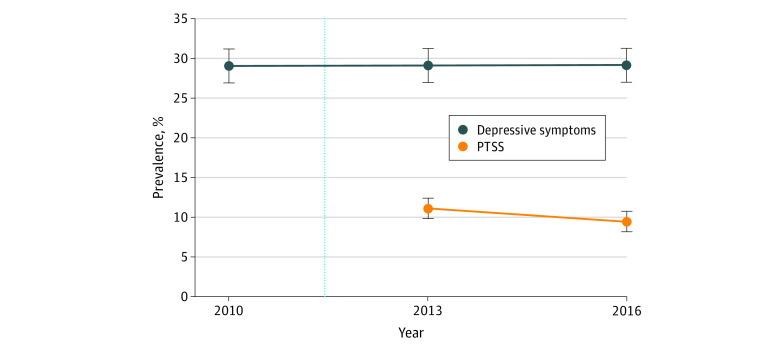
Prevalence of Posttraumatic Stress Symptoms (PTSS) and Depressive SymptomsError bars indicate 95% CIs.